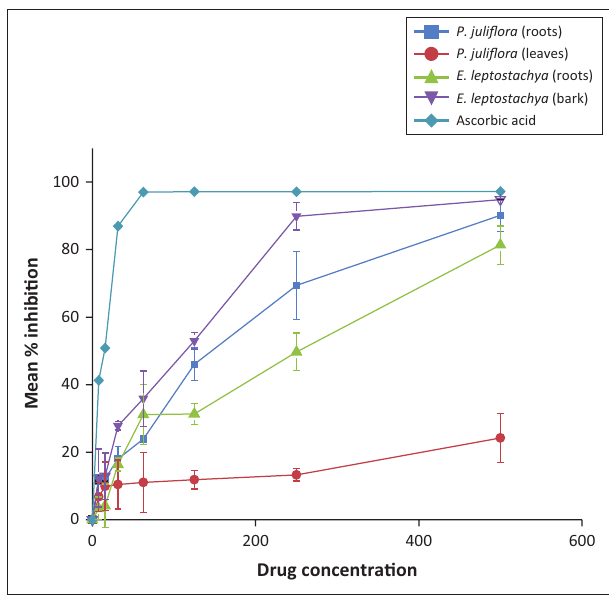
FIGURE 5: A graph of mean per cent inhibition against plant extract concentration (µg/mL). TABLE 3: Effective concentration of extracts required to scavenge 50 % 2,2-diphenyl-1-picrylhydrazyl. Extract EC